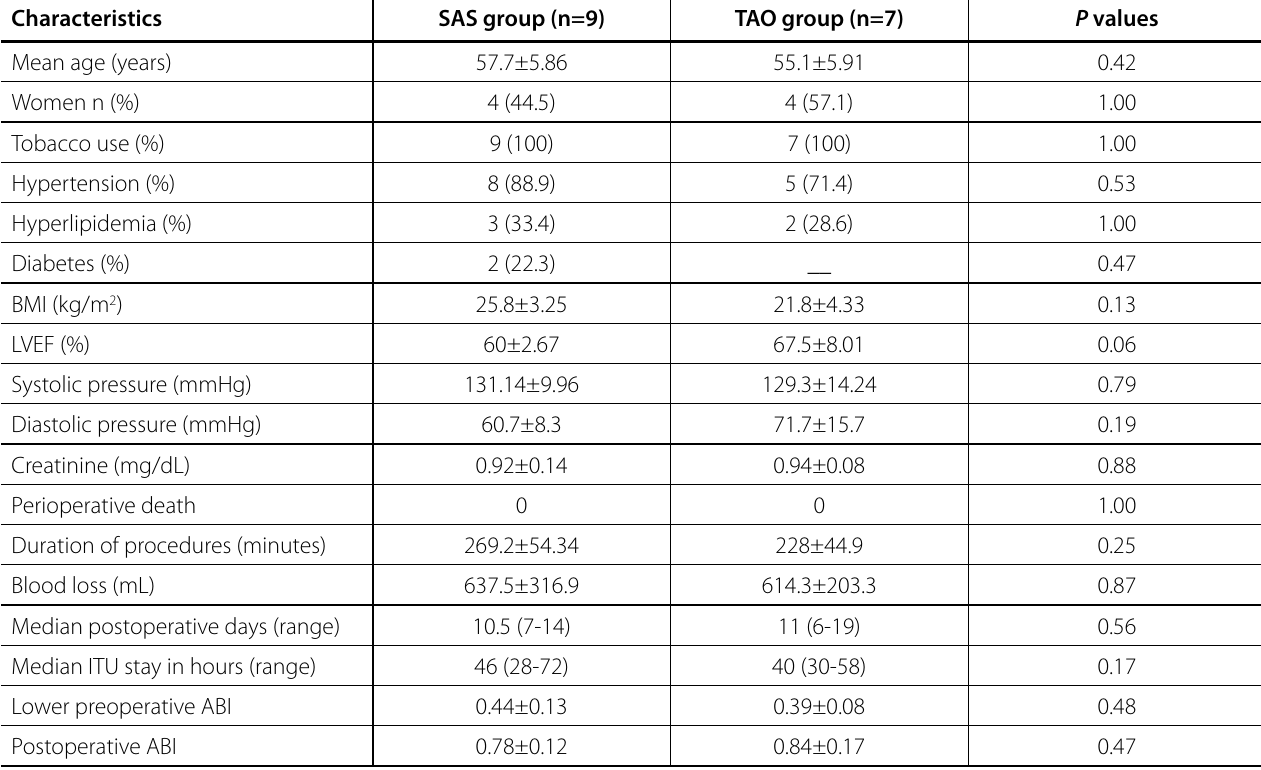
Table 1. Clinical characteristics and surgical data of patients with severe aortoiliac stenosis (SAS) and totally aortoiliac occlusion (TAO) submitted to aortobifemoral bypass.